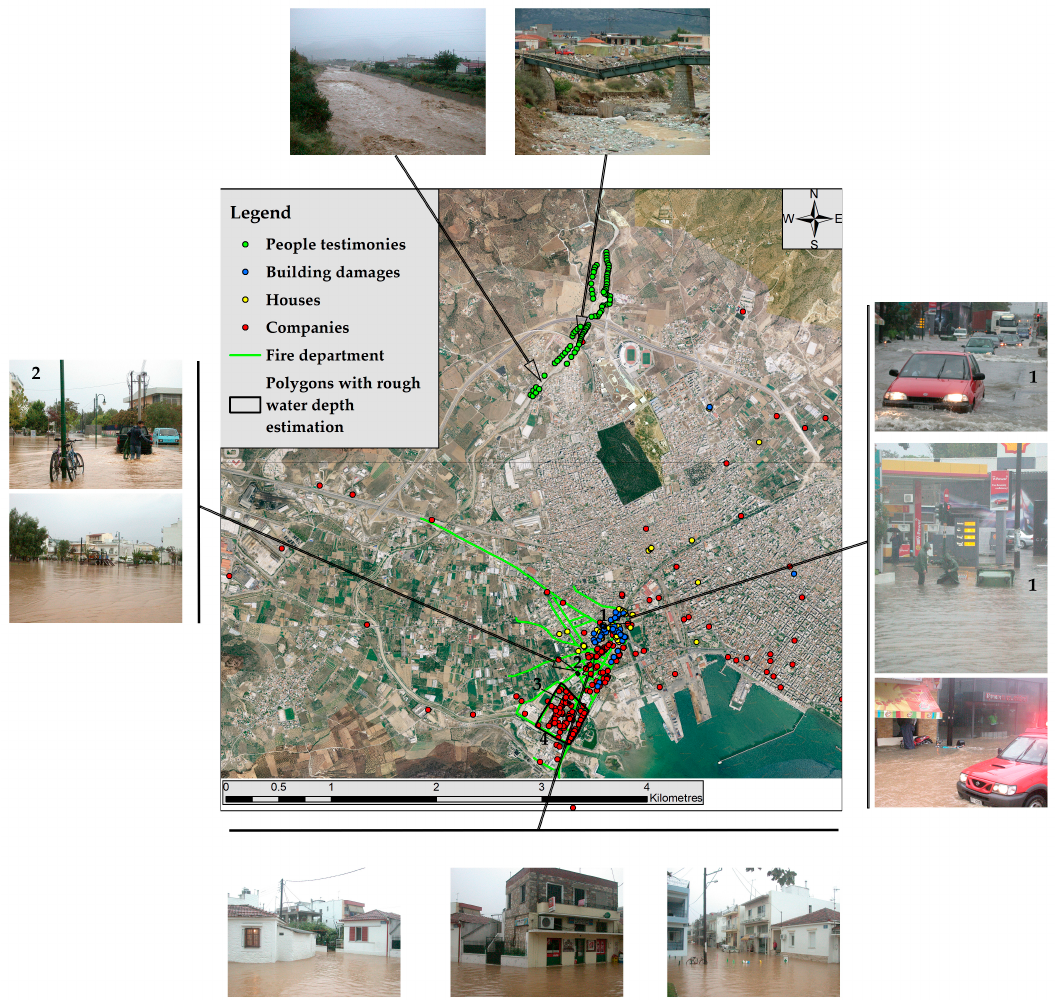
Figure 2. Spatial distribution of the flood data (event of 9 October 2006) collected by several conventional and unconventional sources. Numbers denote the polygon locations and the related photographs of the selected areas used for rough water depth